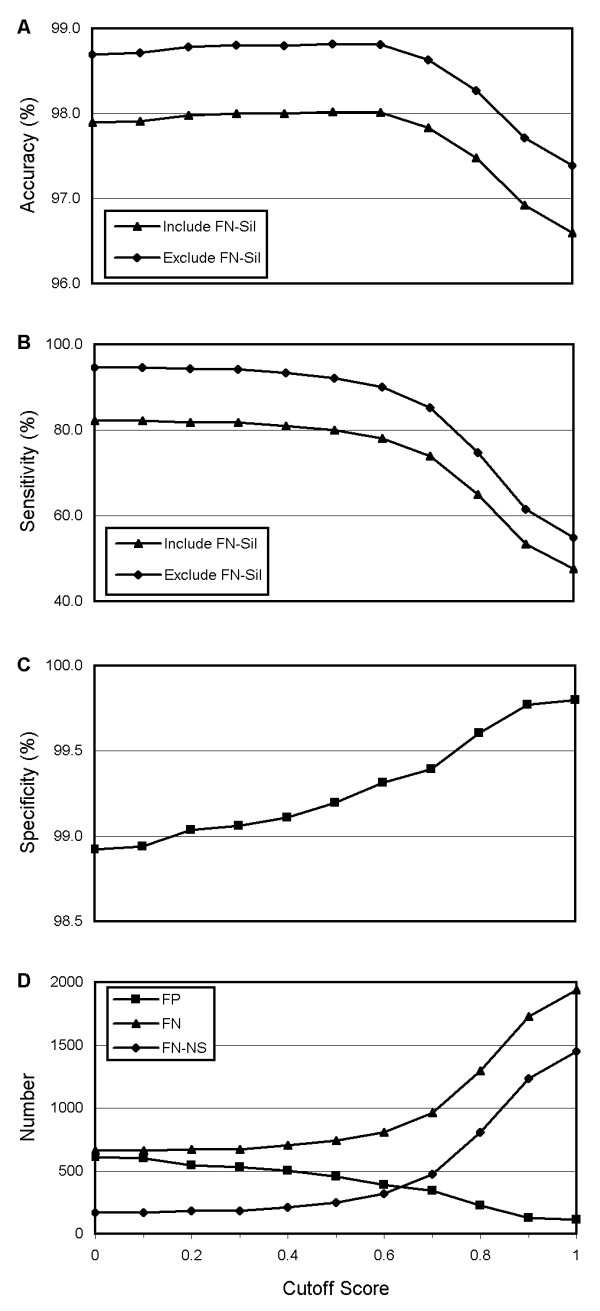
Effect of the cutoff score on PREP-Mt predictive performance. Effect of the cutoff score as measured by (A) accuracy, (B) sensitivity, (C) specificity, and (D) the numbers of false positives (square), false negatives (triangle), and non-silent false negatives which change the encoded amino acid (diamond). Accuracy and sensitivity were calculated using either all false negatives (triangle) or only the false negatives that change the encoded amino acid (diamond). Cutoff values used for testing ranged from 0 to 1.0 at all increments of 0.1.